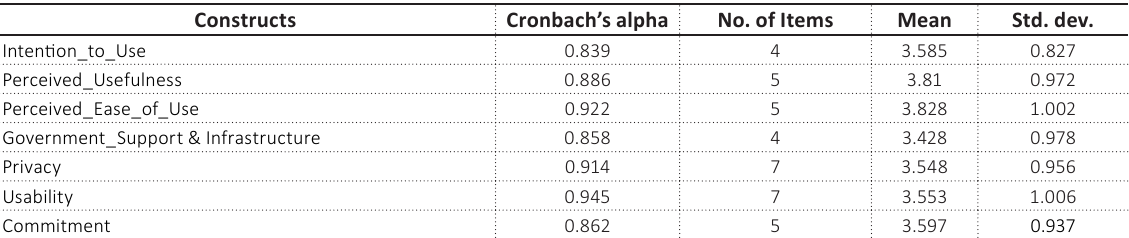
Table 3. Reliability analysis